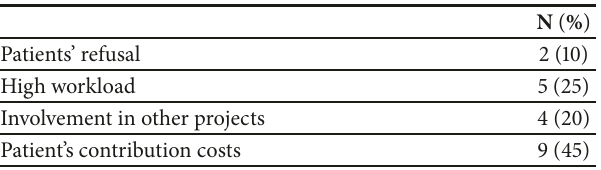
Table 1: Declared reasons for low enrolment by the 20 GPs participating in the program.